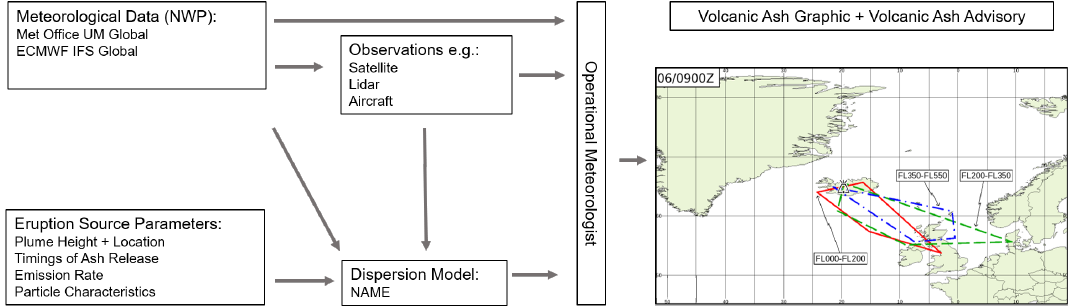
Figure 1. The forecasting process at the London Volcanic Ash Advisory Centre, which follows the processes of the International Airways Volcano Watch [4]. The dispersion model NAME is initialized with observations of the eruption (the Eruption Source Parameters) and driven by Numerical Weather Prediction meteorological data. Simulations are compared to observations by operational meteorologists, including satellite imagery, lidar retrievals, observations made by research aircraft, and pilot reports. The uncertainty around the forecast meteorological situation and model inputs are considered before generating the VAA and